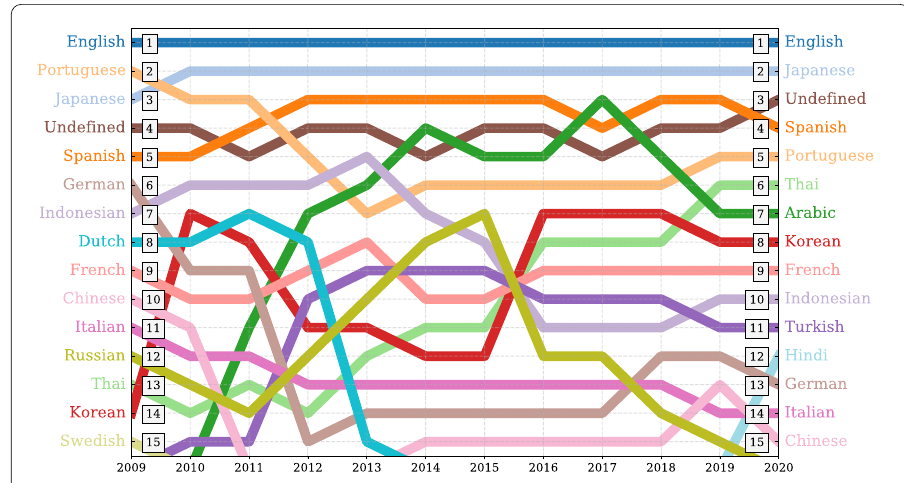
Figure 3 Annual average rank of the most used languages on Twitter between 2009 and 2019. English and Japanese show the most consistent rank time series. Spanish, and Portuguese are also relatively stable over time. Undefined—which covers a wide variety of content such as emojis, links, pictures, and other media—also has a consistent rank time series. The rise of languages on the platform correlates strongly with international events including Arab Spring and K-pop, as evident in both the Arabic and Korean time series, respectively. Russian, German, Indonesian, and Dutch moved down in rank. This shift is not necessarily due to a dramatic drop in the rate of usage of these languages, but is likely an artifact of increasing growth of other languages on Twitter such as Thai, Turkish, Arabic, Korean,